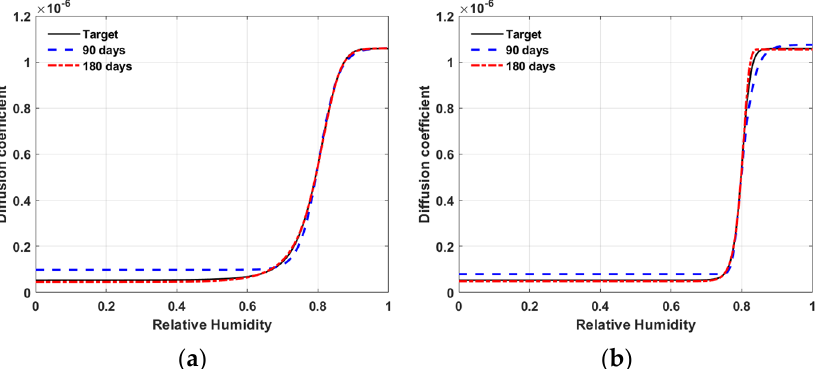
Figure 12. Results of inverse estimation using N1—target model versus ANN model ( a ) material M1; ( b ) material M2.